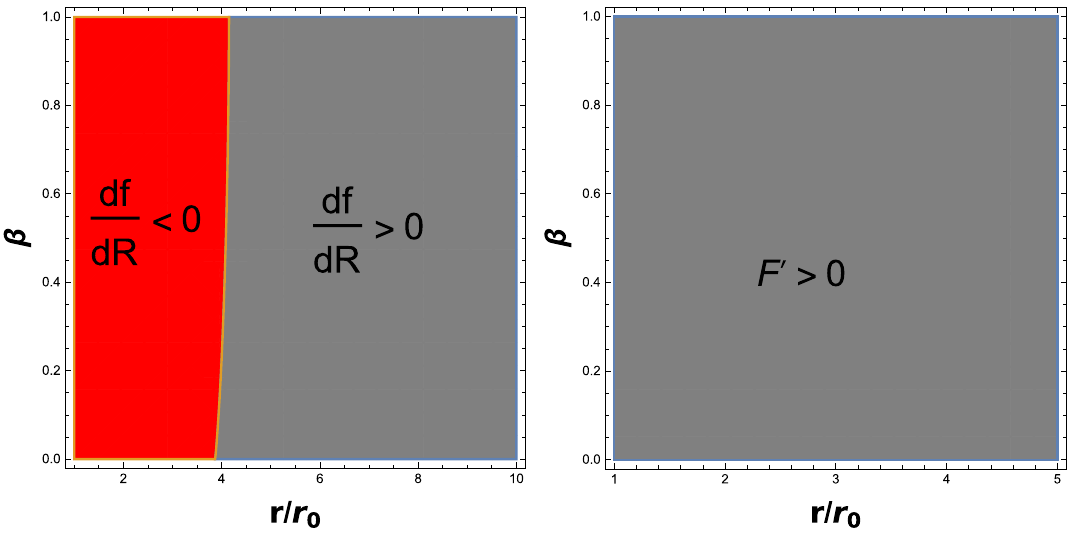
< 0 (left side) and gray region shows F (cid:5) > 0, for shape function (cid:6)( r ) = r 0 Log [ 1 + r ] dR